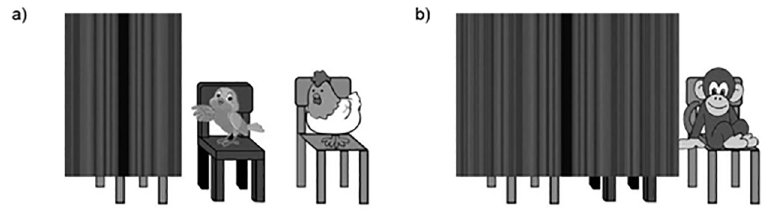
Figure 2. Updating task: first (a) and second (b)